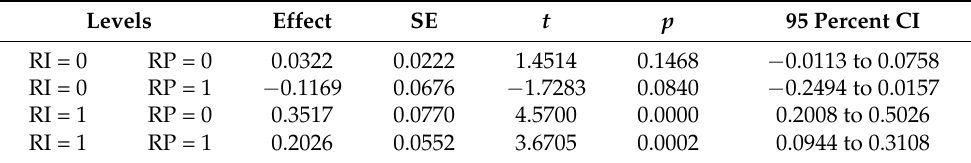
Table 4. Conditional effects of traditional media usage on moral evaluation under different religious identity and religious practice